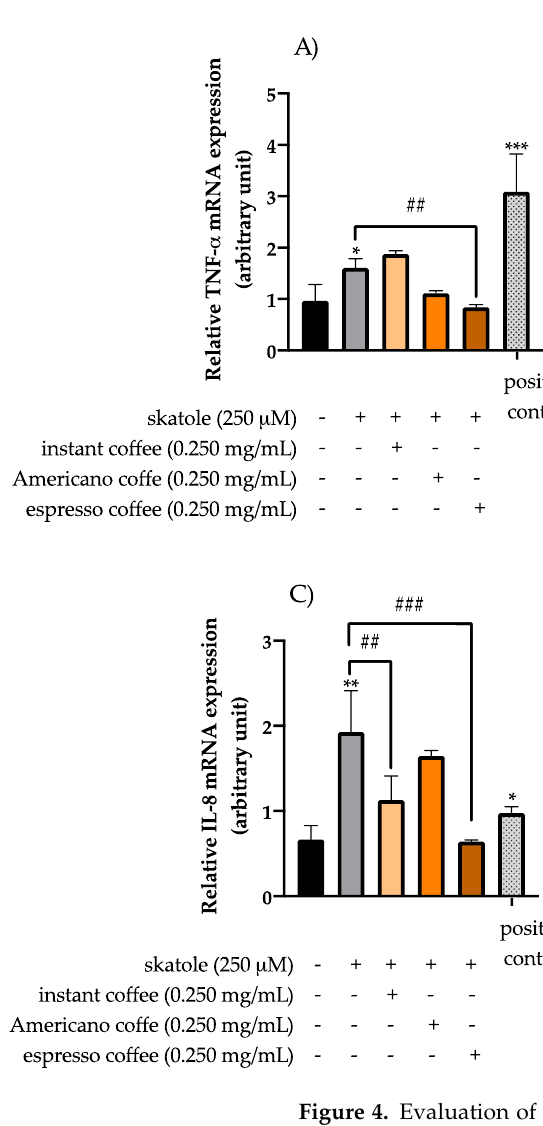
Figure 4. Evaluation of mRNA expression levels in HT-29 cells. The effect of treatment with the different types of coffee extract (instant, Americano and espresso) at 0.250 mg/mL after stimulation with 250 µM skatole on the expression level of TNF- α ( A ), IL- 1β ( B ), IL-8 ( C ), and IL12 ( D ) was performed using real-time PCR analysis after 24 h of treatment, and compared to the control group. Cells treated only with LPS were used as a positive control. The graph represented the mean and SD of three separate experiments. * p - value ≤ 0.05, ** p - value ≤ 0.01 and *** p - value ≤ 0.001 compared to untreated control. # p - value ≤ 0.05, ## p - value ≤ 0.01 and ### p - value ≤ 0.001 skatole versus coffee